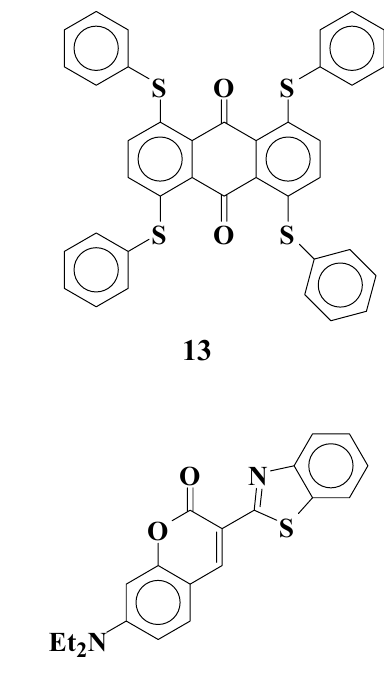
Figure 8. The molecular structures of calculated anthraquinone and coumarin